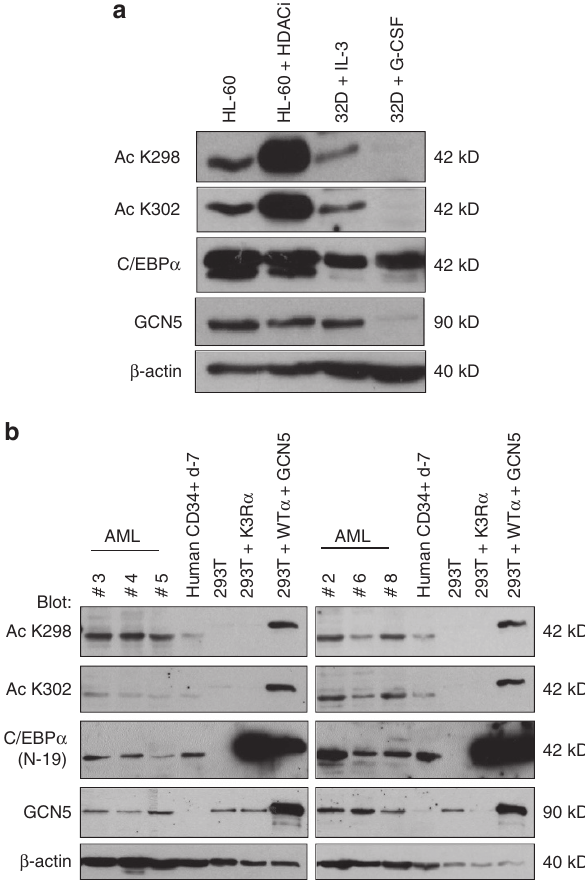
Figure 2 | Loss of C/EBP a acetylation on granulocytic differentiation and detection in primary AML samples. ( a ) 32Dcl3 murine IL-3 dependent cells are differentiated into granulocytes with addition of G-CSF for 4 days. Western blot analysis showed nuclear extracts using anti acetyl K298, K302, C/EBP a (D56F10), GCN5, and b -actin antibodies. HL-60 cells